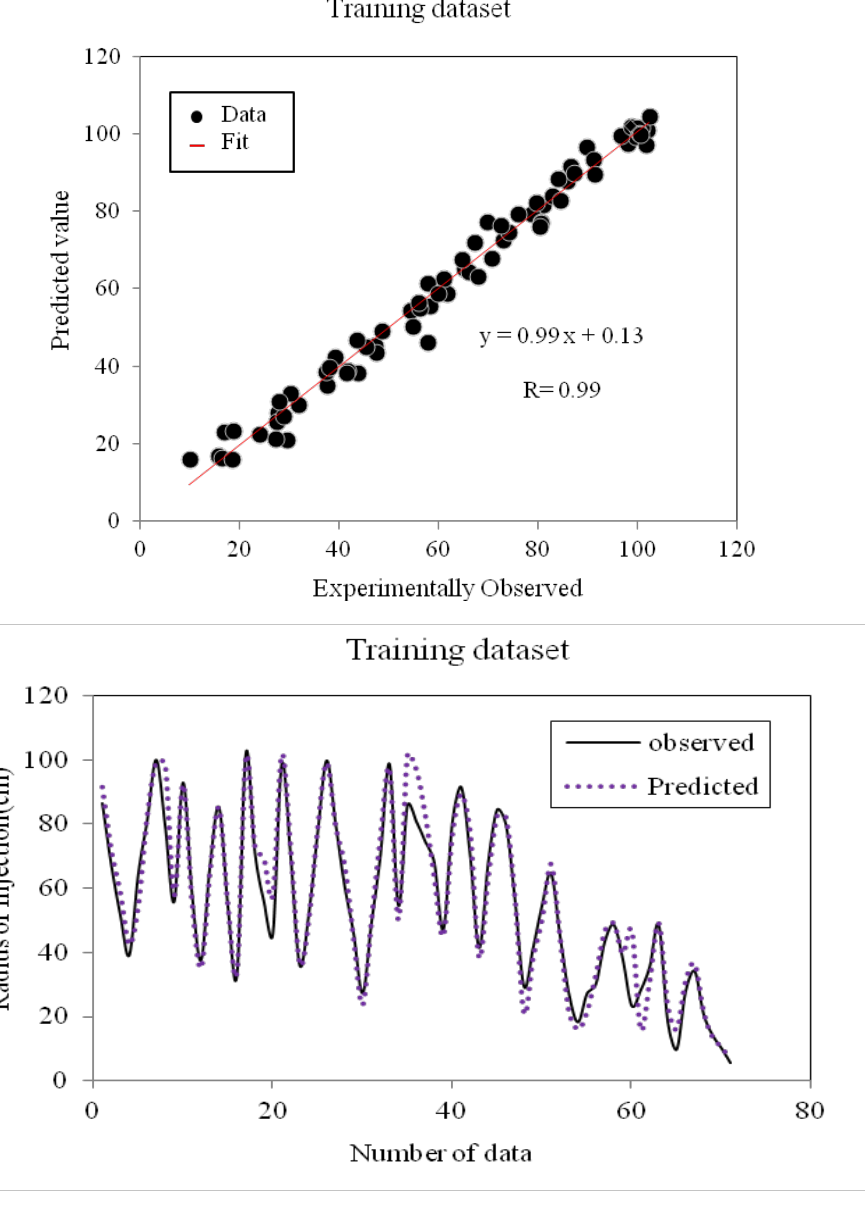
Fig. 8. Comparison of the experimentally observed and ANN predicted values for training